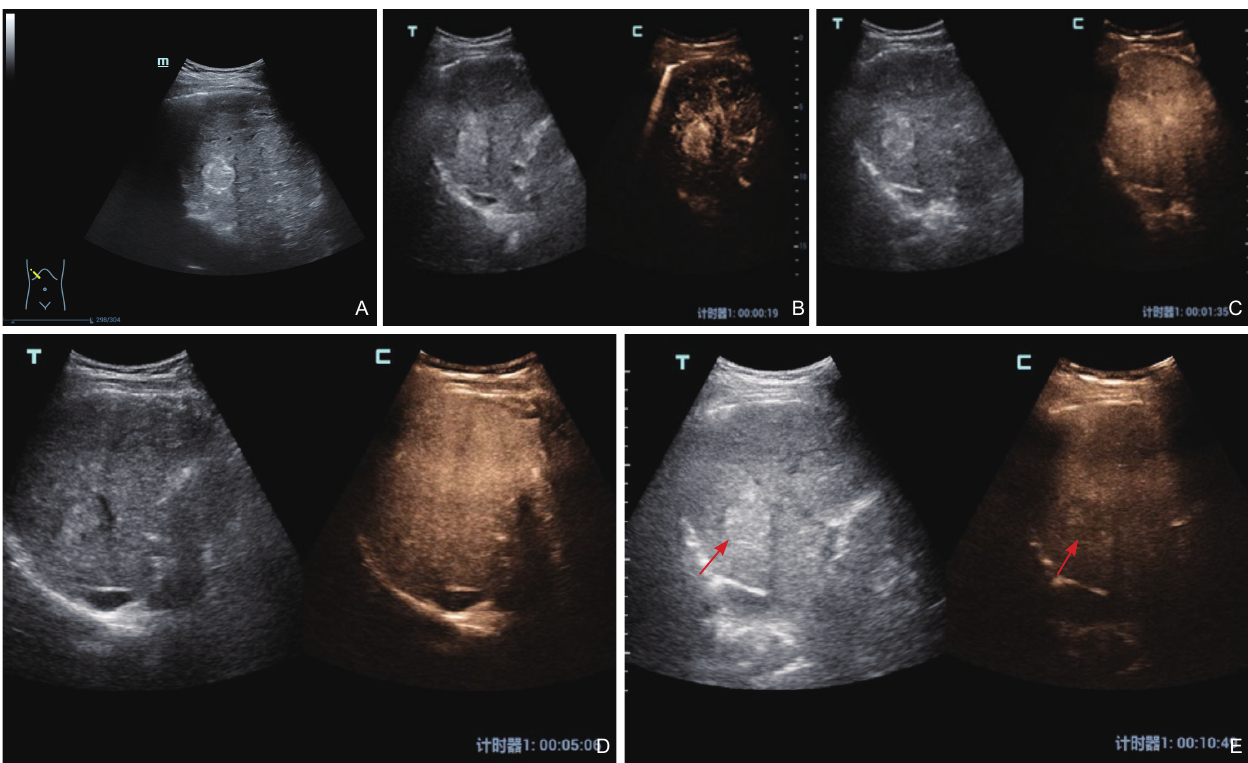
Figure 2 The images of Sonazoid-CEUS. (A) Gray scale ultrasound (left) showed a hyper-echoic, clear margin, round shape lesion in Segment VII; (B- D) the lesion was hyper-enhanced in the arterial phase with consistent iso-enhanced in the portal and late phase and cannot be distinguished; (E) it showed a defect of contrast agent in Kupffer phase